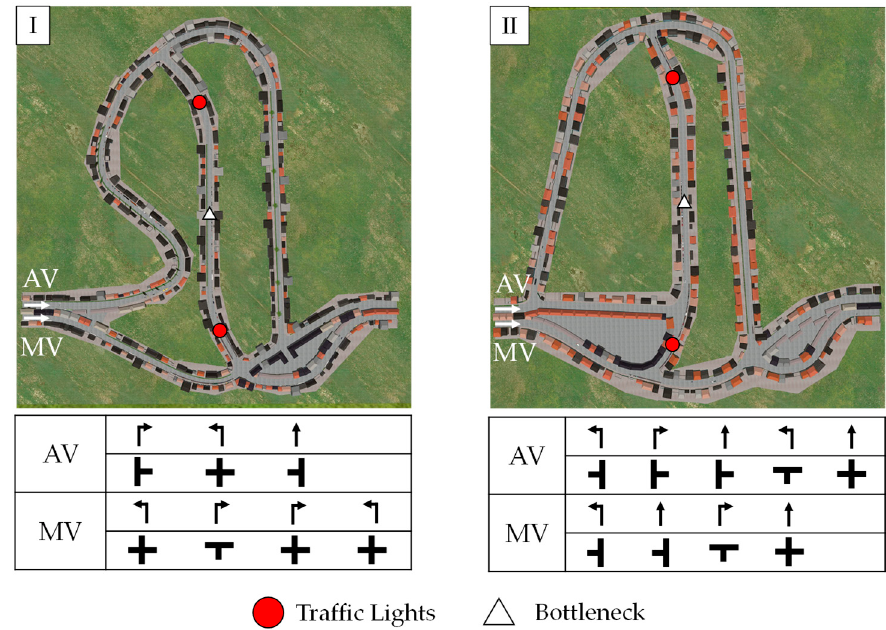
Figure 5. Course design consisting of two modules (Module I and Module II) the participants passed through during the experiment. Additionally, the navigation through the modules of the AV and the manual vehicle (MV) is presented.